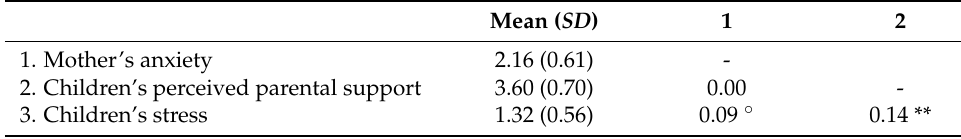
Table 1. Means, standard deviations, and Pearson correlations between variables.